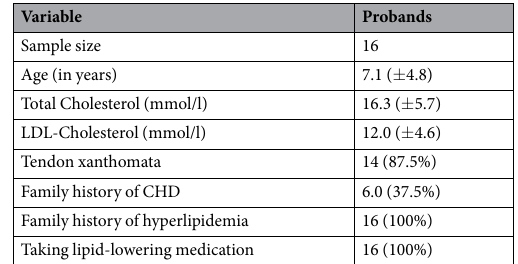
Table 1. Baseline characteristics (mean ± SD) used in this